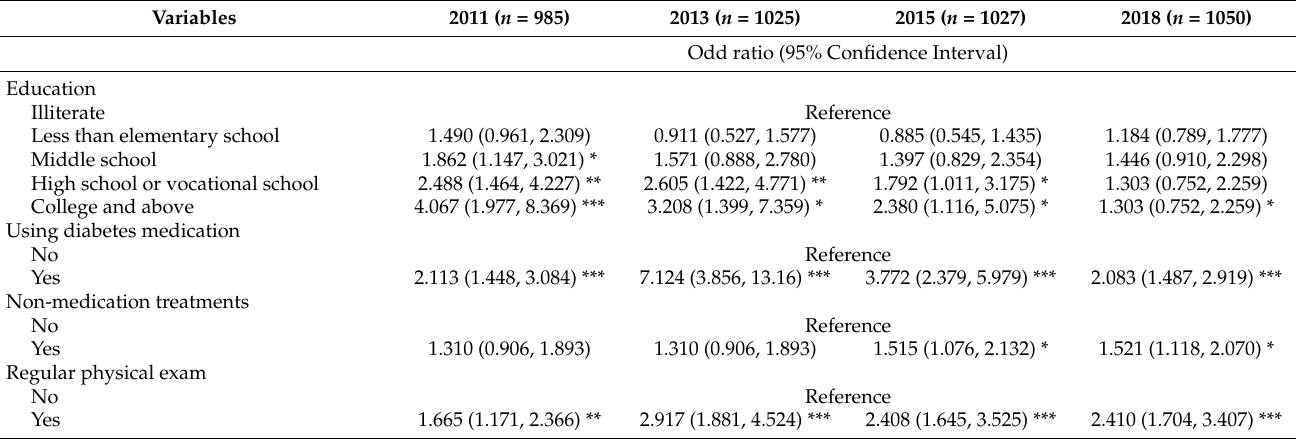
Table 3. Multivariate logistic regression of factors associated with adherence to annual fundus